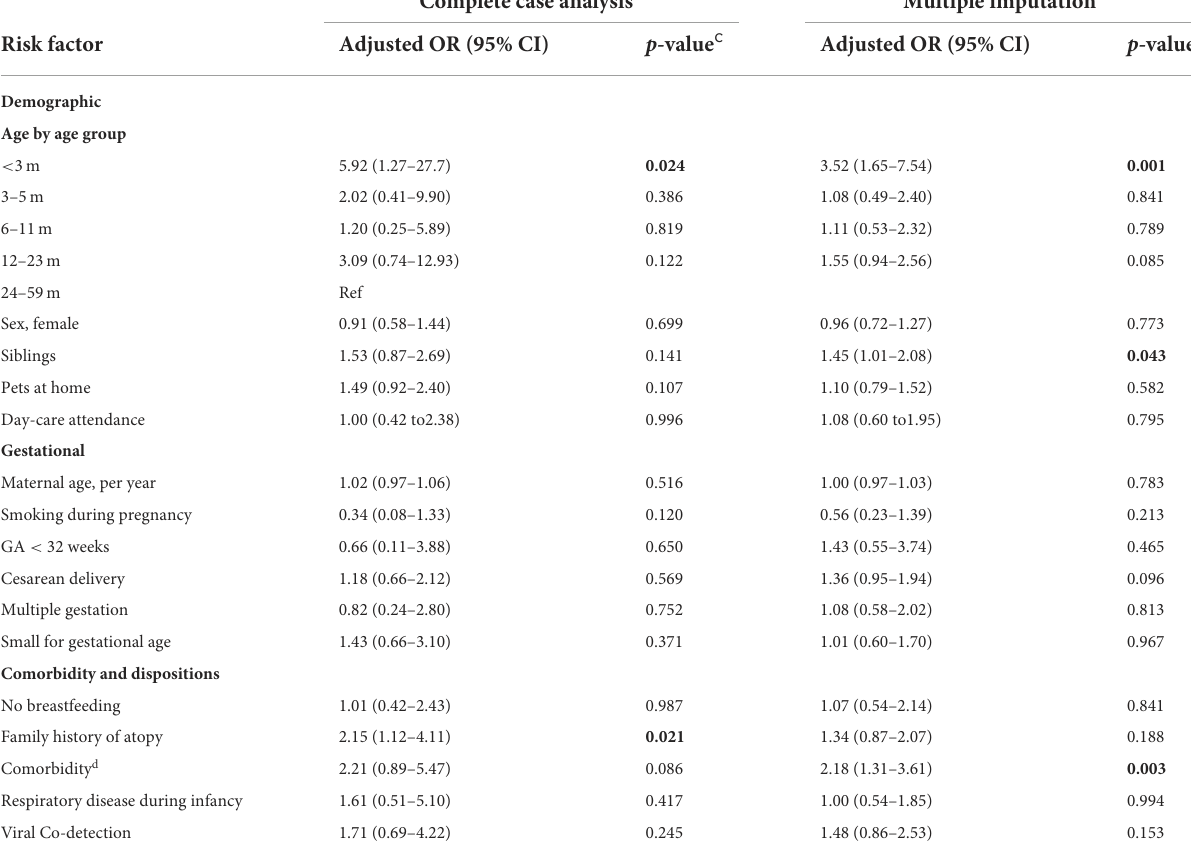
TABLE 4 Risk factors for length of stay over 72h in RSV positive children under 5 years of